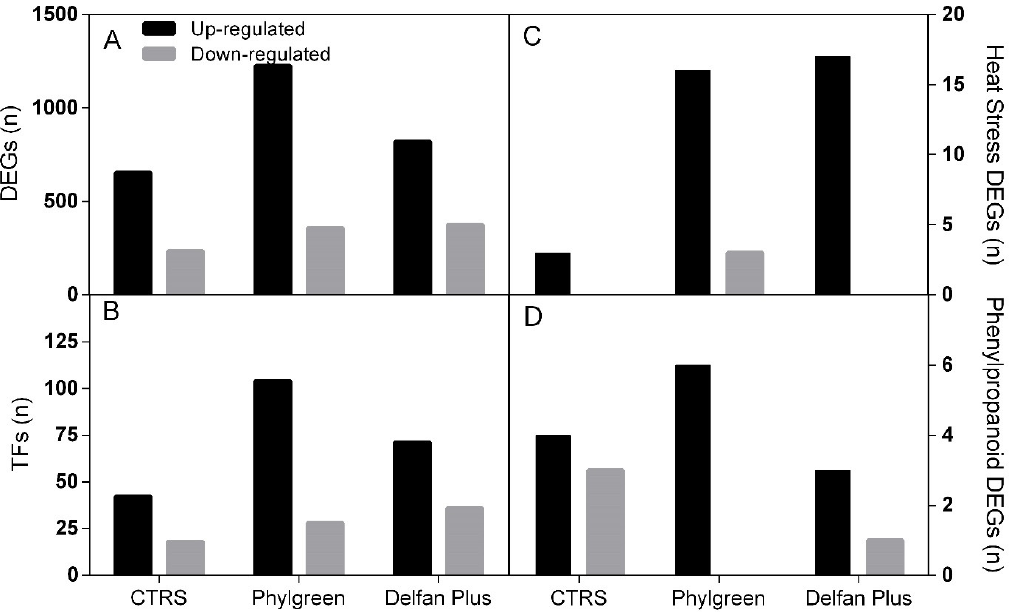
Figure 2. Total differently expressed genes ( A ), transcription factors (TFs) ( B ), heat stress-associated genes ( C ), phenylpropanoids ( D ) in CTRS, Phylgreen, and Delfan Plus.